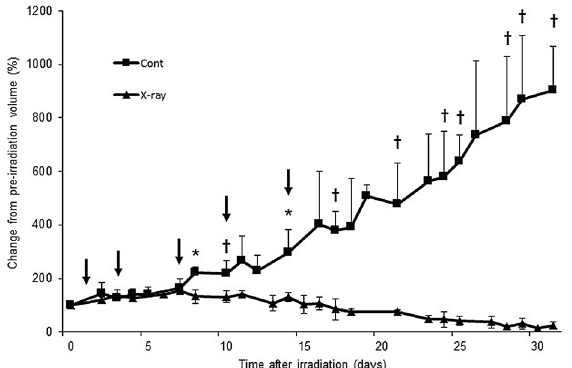
Figure 1. Time-dependent change in tumor volume of LNZ308 tumors after irradiation. Tumors on right paws were irradiated on day 0 at a dose of 60 Gy. Each point represents mean ± SD of the change from